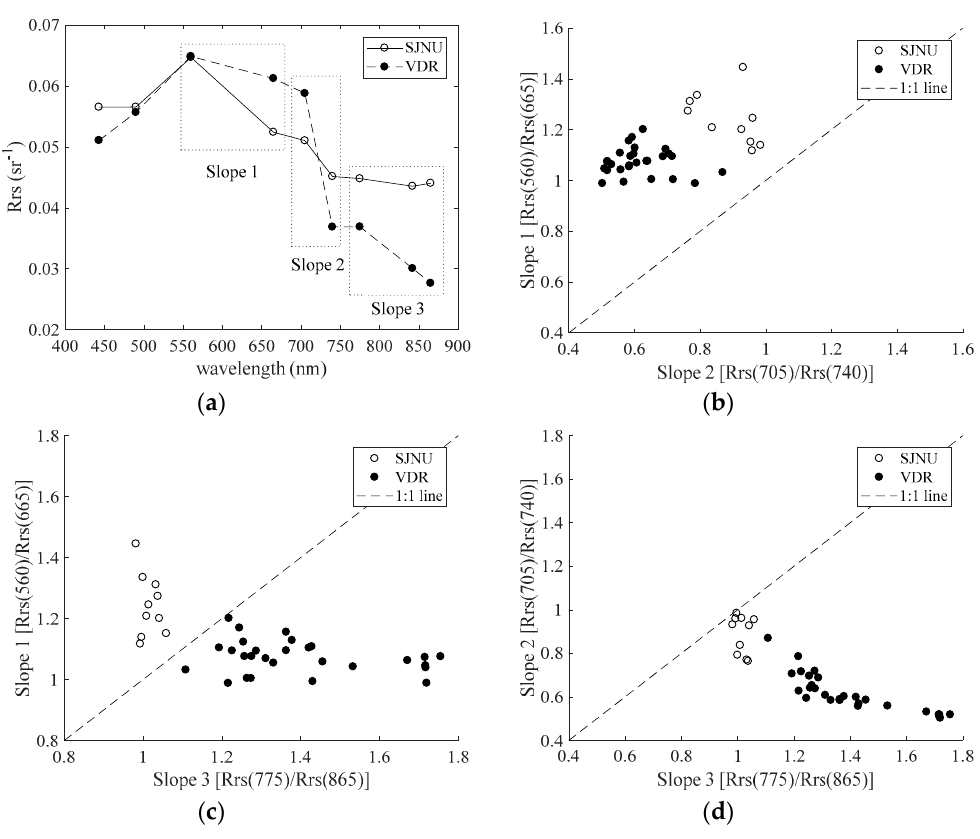
Figure 11. Separation method of the Lake Shinji and Lake Nakaumi (SJNU) and Vaal Dam Reservoir (VDR) types. ( a ) Average spectral reflectance ( R rs ) characteristics (Multispectral Imager band only) of all R rs data in SJNU and VDR; ( b ) relationship between Slope 1 ( R rs (560)/ R rs (665)) and Slope 2 ( R rs (705)/ R rs (740)); ( c ) relationship between Slope 1 ( R rs (560)/ R rs (665)) and Slope 3 ( R rs (775)/ R rs (865)); ( d ) relationship between Slope 2 ( R rs (705)/ R rs (740)) and Slope 3 ( R rs (775)/ R rs (865)).